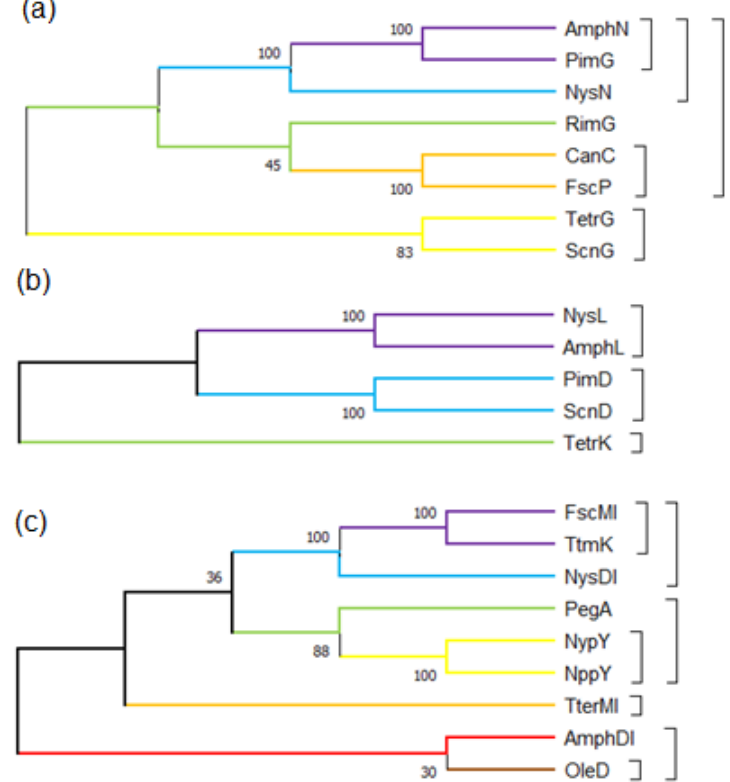
Figure 2. Phylogenetic tree of the post-PKS modifying proteins of some polyene macrolides. The evolutionary history was inferred using the neighbor-joining method. ( a ) Phylogenetic tree of carboxylating CYP450 enzymes; ( b ) phylogenetic tree of hydroxylating or epoxidizing CYP450 enzymes; ( c ) phylogenetic tree of glycosyltransferase.